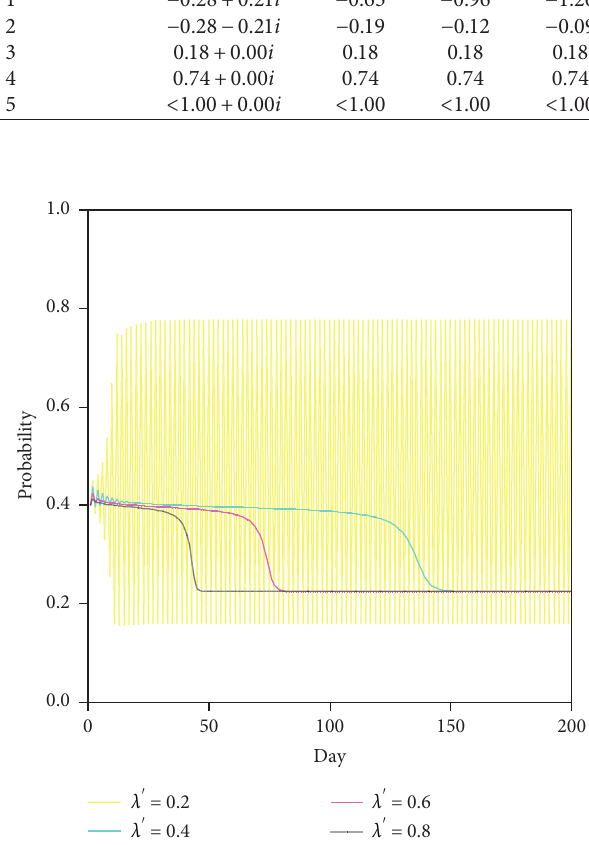
Figure 2: Evolution of link 1 chosen probabilities under different λ ′ values.